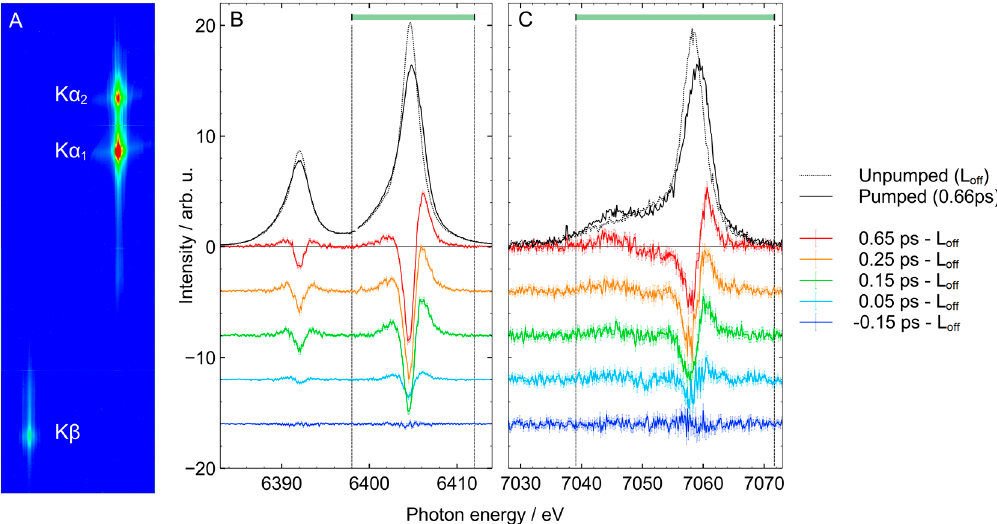
Figure 3. ( A ) Simultaneous measurement of Fe K α and K β emission spectra on a Jungfrau 500k detector (only the exposed half of the detector active area is shown, blue and red colors correspond to low and high intensity signals, respectively); the extracted iron K α ( B ) and K β ( C ) spectra and the respective di ff erence traces for a set of selected pump-probe time delays. The “Unpumped” and “Pumped” curves correspond to emission spectra without (laser OFF) and with (laser ON) laser excitation, respectively. The K α di ff erence traces are multiplied by a factor of 2 for better visibility. The error bars on the plots correspond to one standard deviation of the mean for the respective datasets. The green horizontal bars above the spectra in ( B ) and ( C ) denote the region used for (squared) integration to generate the data points in Figure